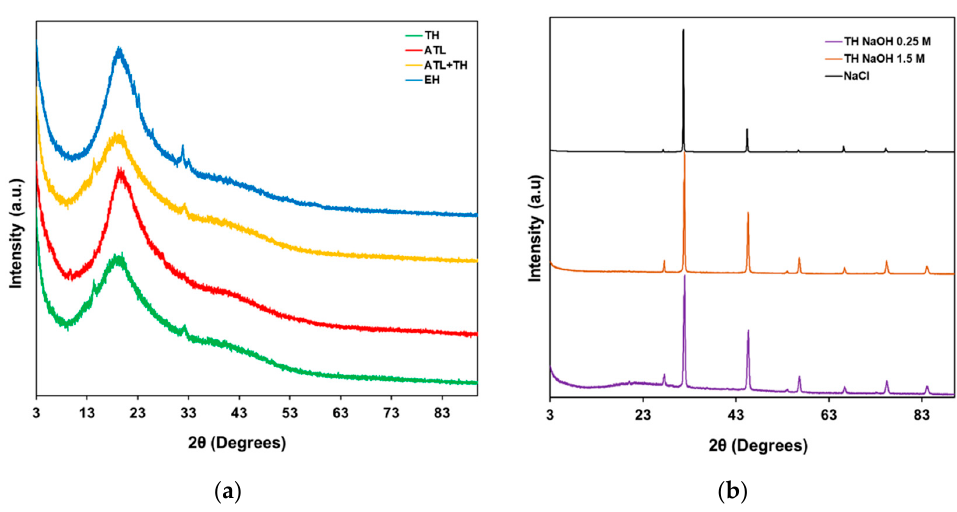
Figure 2. Powder X-Ray Diffraction analyses of the mannans extracts correspondent to the following extraction methods: ( a ) pH neutral Thermal Hydrolysis (TH), Autolysis (ATL), Autolysis followed by pH-neutral Thermal Hydrolysis (ATL + TH) and Enzymatic Hydrolysis (EH); and ( b ) alkaline Thermal Hydrolysis (TH NaOH 0.25 M and TH NaOH 1.5 M) and commercial NaCl. The PXRD patterns of the mannans extracts obtained by pH neutral hydrolysis (TH), autolysis (ATL) or even the product resulting from the combination of both previous methods (ATL + TH), along with the extract obtained by enzymatic hydrolysis (EH), exhibit a broad diffraction at 2 θ = 19.7°, which is consistent with the predominant amorphous character (Figure 2a) [53]. However, the PXRD analysis of the products resulting from the alkaline thermal hydrolysis (Figure 2b), using different NaOH concentrations of 0.25 and 1.5 M, TH NaOH 0.25 M and TH NaOH 1.5 M, respectively, revealed the presence of NaCl—produced in the neutralization reaction of NaOH and HCl—with both samples exhibiting the characteristic diffraction peaks of NaCl (27.5°, 31.7°, 45.4°, 53.7°, 56.6°, 66.2°, 75.5°and 84.1°) [54]. These extracts, resulting from the alkaline extraction processes, require further purification steps in order to prompt the salt removal, namely by further washing with water, or even by desalination. The morphology of all mannans extracts was evaluated by Scanning Electron Micros- copy (SEM), as highlighted in Figure 3.